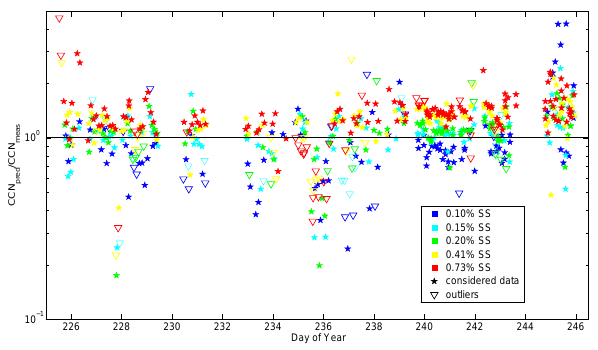
Fig. 7. Time series of CCN pred / CCN meas for the five supersatu- ration using the parameters of permutation 13 ( κ org = 0 . 0, κ sulf = 0 . 61, ρ org = 1gcm − 3 ).